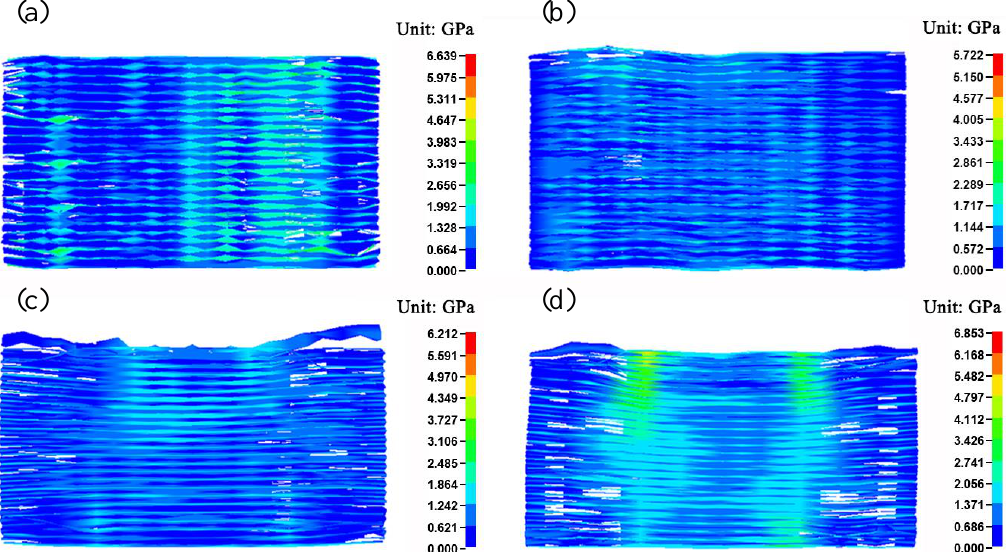
Figure 8. Stress nephogram of longitudinal section of Ti–Al3Ti–Al laminated composites with different Al contents: ( a ) 0% Al, ( b ) 10% Al ( c ), 20% Al, ( d )